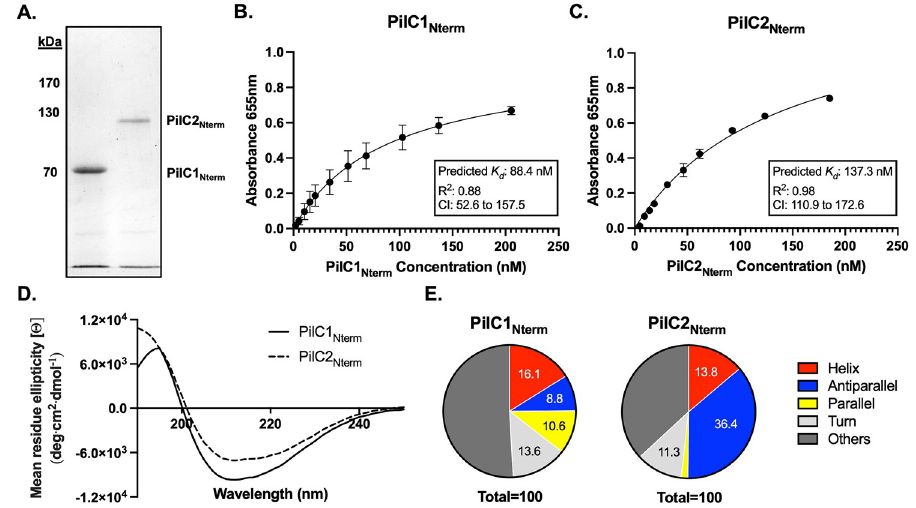
Fig 5. The PilC1 and PilC2 N-terminal domains bind to epithelial cell monolayers. (A) Recombinant PilC1 N- terminal domain (PilC1 Nterm ) and PilC2 N-terminal domain (PilC2 Nterm ) were purified and separated on a 7.5% SDS PAGE gel and stained with Coomassie blue. (B, C) Proteins were added to monolayers of Chang epithelial cells of HeLa origin at increasing concentrations in 50 mM Tris-HCl, pH 8.5. Adherence was detected by ELISA using polyclonal antiserum CHP-R1 for PilC1 Nterm (B) or GP103 for PilC2 Nterm (C) and a secondary anti-rat or anti-guinea pig antibody conjugated to HRP. Non-linear regressions were fit using the GraphPad Prism one site specific binding model fit to total data from 3 independent runs, and the K d was calculated based on the regression. Error bars represent standard error of the mean, n = 3. (D, E) Circular dichroism was carried out on purified PilC1 Nterm and PilC2 Nterm (D) and the resultant spectra were used to predict protein secondary structures (E). The CD spectra are representative graphs of three independent analyses carried out on different batches of purified protein. retraction-deficient Δ pilT mutant were completely non-transformable. Strain KK03 Δ pilC1 Δ-